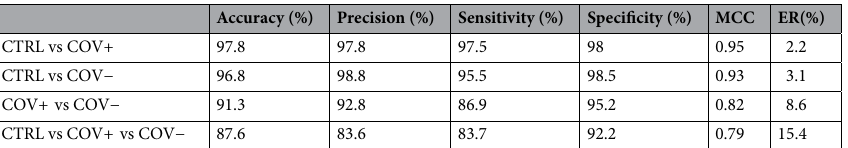
Table 3. Accuracy, precision, sensitivity, specificity, Matthews correlation coefficient (MCC) and error-rate for cross-validation sum on the single spectrum (ER) of the four classification models created using the leave-one out